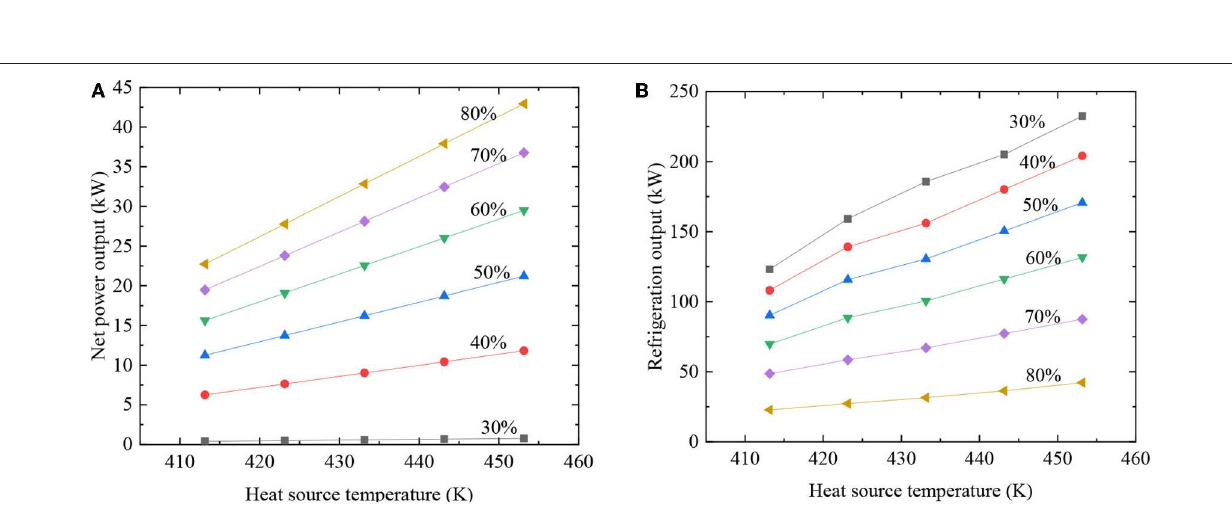
Frontiers in Energy Research |